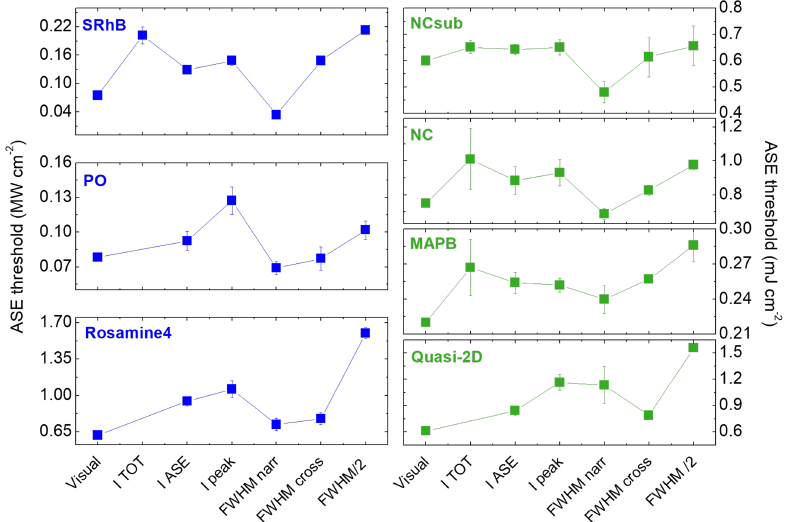
Figure 4. ASE threshold values for SRhB, PO, and rosamine4 (on the left ); NCsub, NC, MAPB and quasi-2D (on the right ), as a function of the adopted